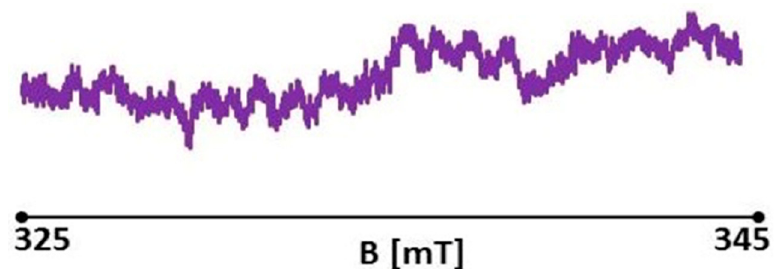
Figure 27. EPR spectrum of healthy skin (control). Spectrum measurement was performed with 15 dB attenuation and 2.2 mW microwave